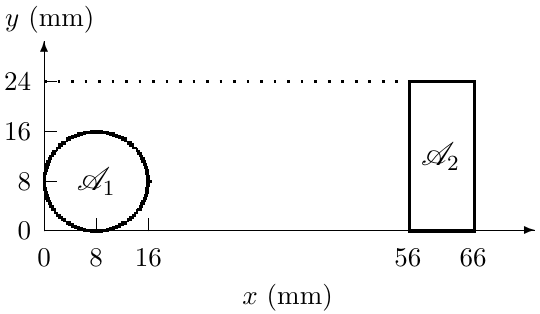
Figure 1. The cross sections of the conductors A 1 and A 2